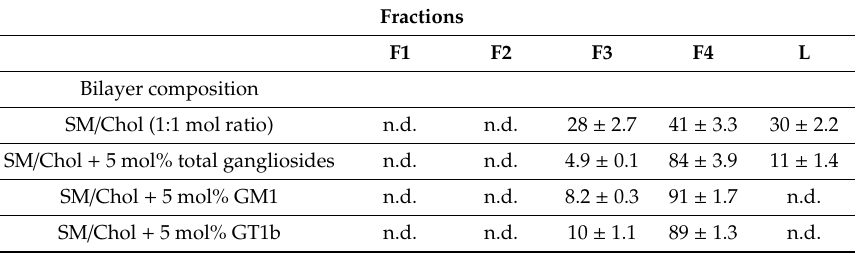
Table 1. Binding of A β 42 to sphingomyelin / cholesterol vesicles in the presence or absence of gangliosides: Flotation assay. Percent distribution of peptide in the various gradient fractions: F1, F2, F3, F4 from bottom to top of the centrifuge tube. L, fraction obtained from washing the tube walls with SDS. Average values ± S.E. (n. d. = not detected).